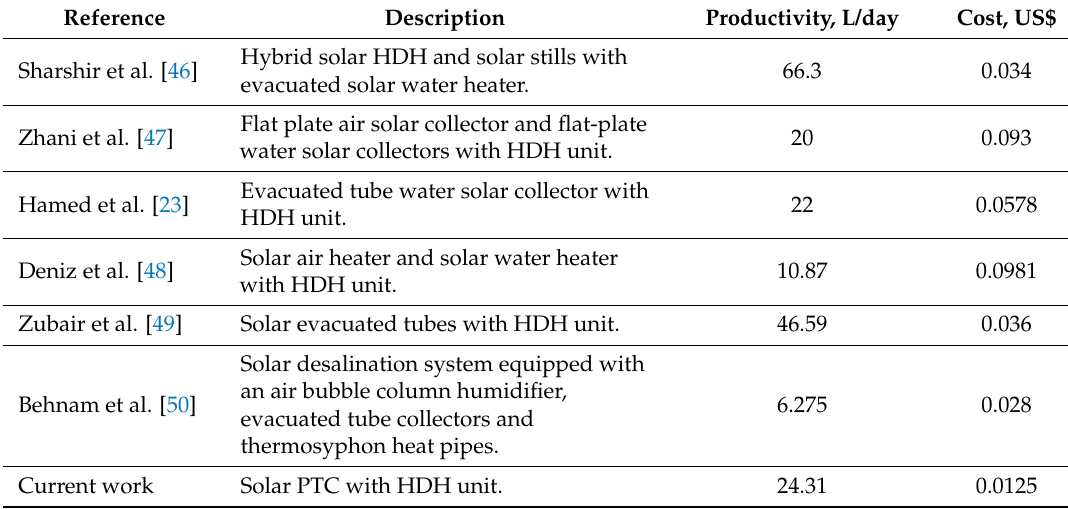
Table 4. Comparison between the current result and previous